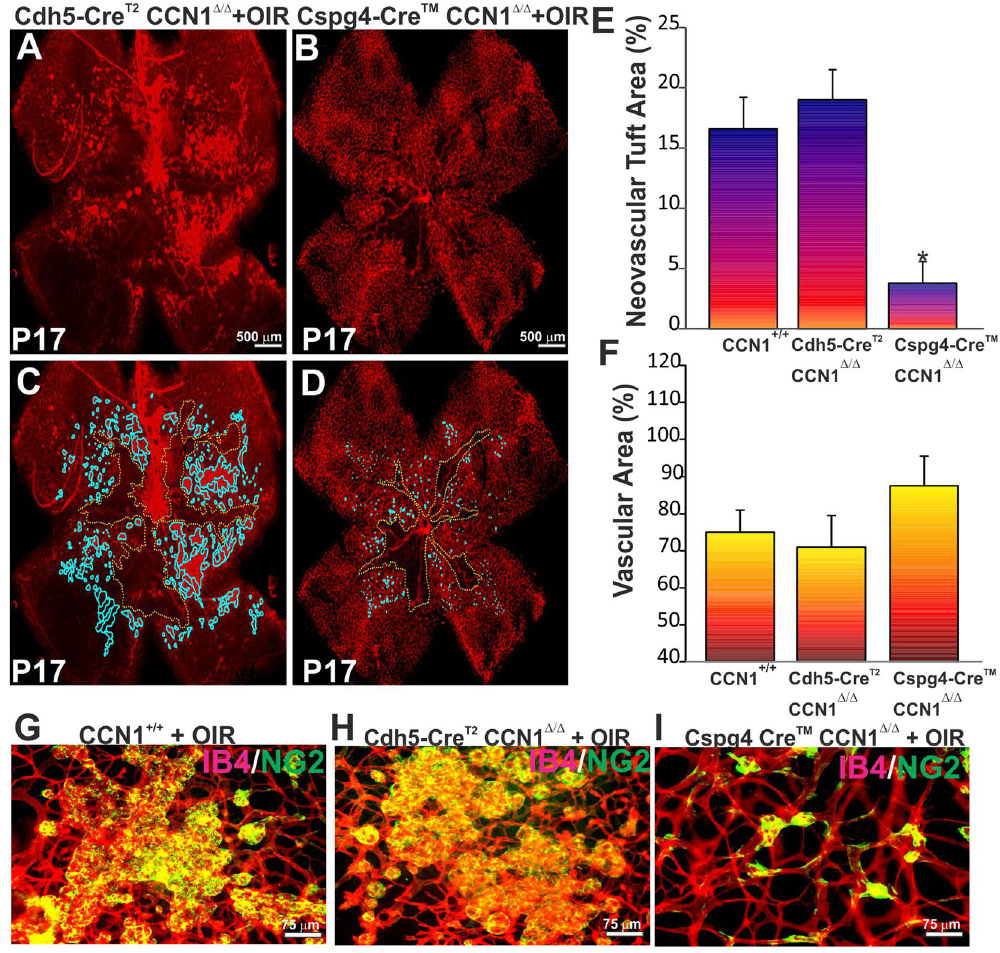
Figure 4. Effects of pericyte-derived CCN1 on pre-retinal neovascularization following OIR. ( A , B ) Representative flat-mount preparations of IB4-stained retinas from CCN1 + / + , Cdh5-CreER T2 CCN1 Δ / Δ and Cspg4-CreER TM CCN1 Δ / Δ mice following OIR. ( C , D ) Areas of pre-retinal neovascular tufts and vaso- obliteration were determined by computer-assisted image analyses (C for A and D for B). ( E , F ) Compiled data showing percentage of neovascular tuft and vascularized areas in Cdh5-CreER T2 CCN1 Δ / Δ and Cspg4-CreER TM CCN1 Δ / Δ mouse retinas. Levels of neovascular and vascularized areas were set to 100% in wild-type OIR mice to facilitate comparisons among animals and groups. * p < 0.001 versus CCN1 + / + and Cdh5-CreER T2 CCN1 Δ / Δ ( n = 4 ). ( G – I ) Double IB4 and NG2 staining of neovascular tufts in retinas from CCN1 + / + , Cdh5-CreER T2 CCN1 Δ / Δ and Cspg4-CreER TM CCN1 Δ / Δ mice depicting neovascular tufts in central retinal areas following OIR. Note the reduced size of tufts (i.e., “microtufts”) in Cspg4- CreER TM CCN1 Δ / Δ